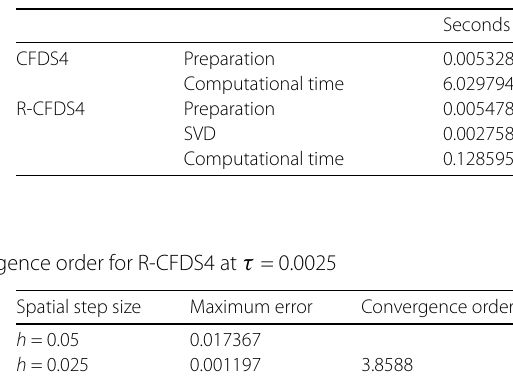
Table 8 The consuming time of two schemes for SP 2 at t = 5, with h = 0.02, τ = 0.01